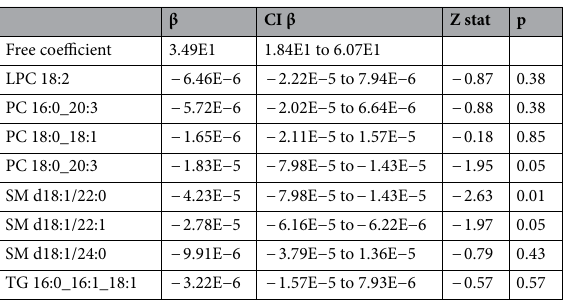
Table 3. Coefficients for logistic regression of diagnostic model “control group/first-time diagnosed UF”.